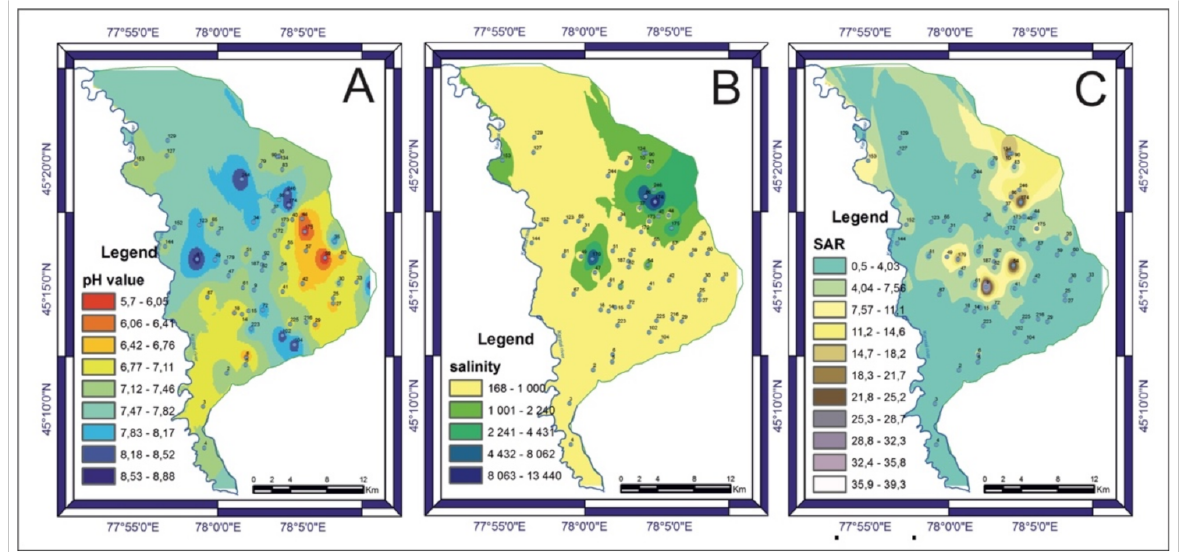
Figure 5. Maps of the spatial distribution of: ( A )—pH, ( B )—salinity, and ( C )—SAR for the post- vegetation